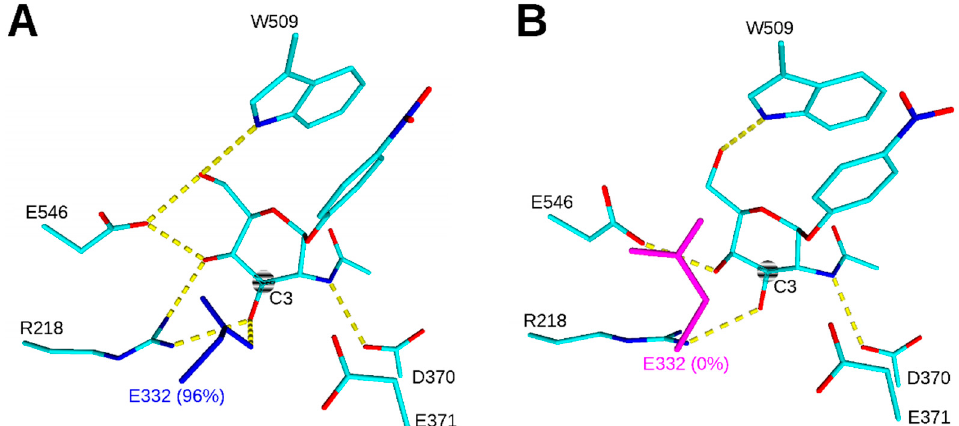
Figure 1. Position of substrates in the active site of Tf Hex WT after 20 ns of molecular dynamics simulation. ( A ) p NP-GlcNAc with Glu332 in blue; ( B ) p NP-GalNAc with Glu332 in magenta. The frequency of occurrence of a hydrogen bond between the substrate C-3 hydroxyl and Glu332 during 15–20 ns of molecular dynamics simulation is shown in brackets. Hydrogen bonds are shown in yellow dashed lines, and hydrogen atoms are hidden. The substrate C-3 atom is highlighted and labeled.